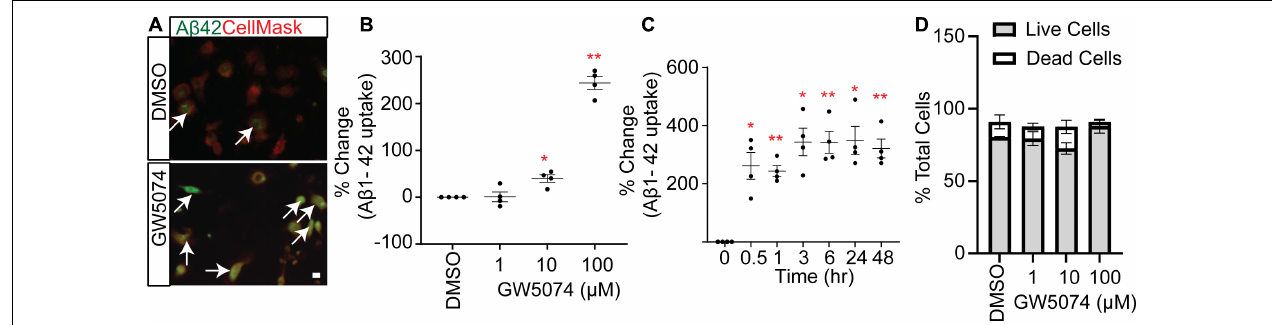
FIGURE 3 | GW5074 optimization in MDMi with amyloid- β 1–42. (A) A representative image of MDMi treated with either DMSO or GW5074 and incubated with HyLite Fluor-488 conjugated A β 1–42 for 2 h. CellMask was used to label the plasma membrane. Arrows indicate increased internalized A β in the GW5074 treated MDMi. (B) MDMi were treated with different concentrations of the drug for 24 h and subsequently incubated with HyLite Fluor-488 conjugated A β 1–42 for 2 h. Cells were imaged on the Celigo Imaging Cytometer (Nexcelom Bioscience) and measured for live cell A β 1–42 signal intensity. (C) Cells were incubated with 100. µ M GW5074 for different time points and the intensity of A β 1–42 was measured. (D) Different doses of GW5074 plotted against cell viability using Live/Dead cell staining kit. No obvious cell death was observed. Data expressed as mean percent change compared to DMSO control. Data were analyzed using Student’s t -test. * p < 0.05, ** p < 0.01. Scale bar, 10 µ m. Each dot represents individual subjects.